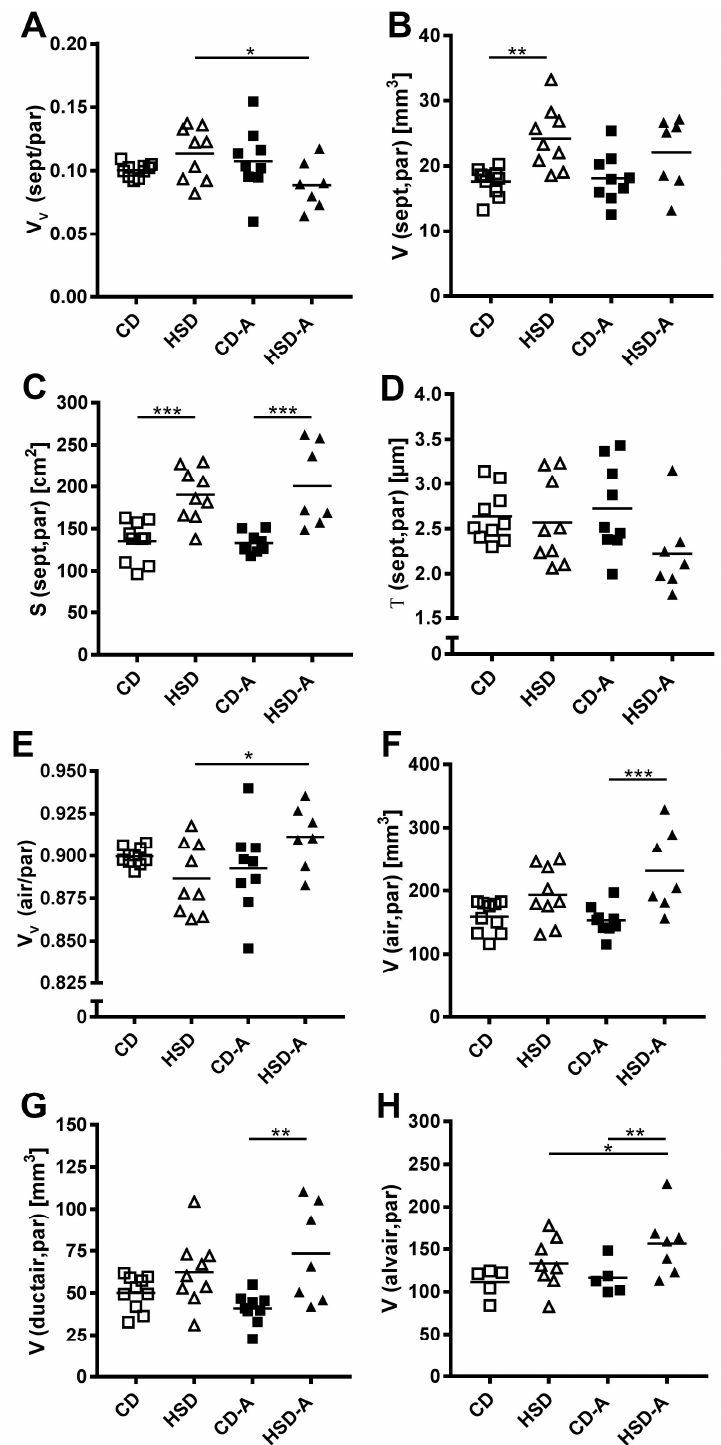
Figure 3. E ff ects of high sucrose intake and voluntary activity on parenchyma composition. Mice were fed a control diet (CD) or a high sucrose diet (HSD) and were left untreated or had access to running wheels (CD-A, HSD-A) for 30 weeks. ( A ) Septal volume density, ( B ) Septal volume, ( C ) Septal surface area; ( D ) Septal thickness; ( E ) Airspace volume density; ( F ) Airspace volume; ( G ) Ductal airspace volume; ( H ) Alveolar airspace volume. Values are individual data points, with means indicated by horizontal lines. Data were compared by 2-Way ANOVA followed by Tukey test; p -values < 0.05 are indicated: * p < 0.05, ** p < 0.01, *** p < 0.001.